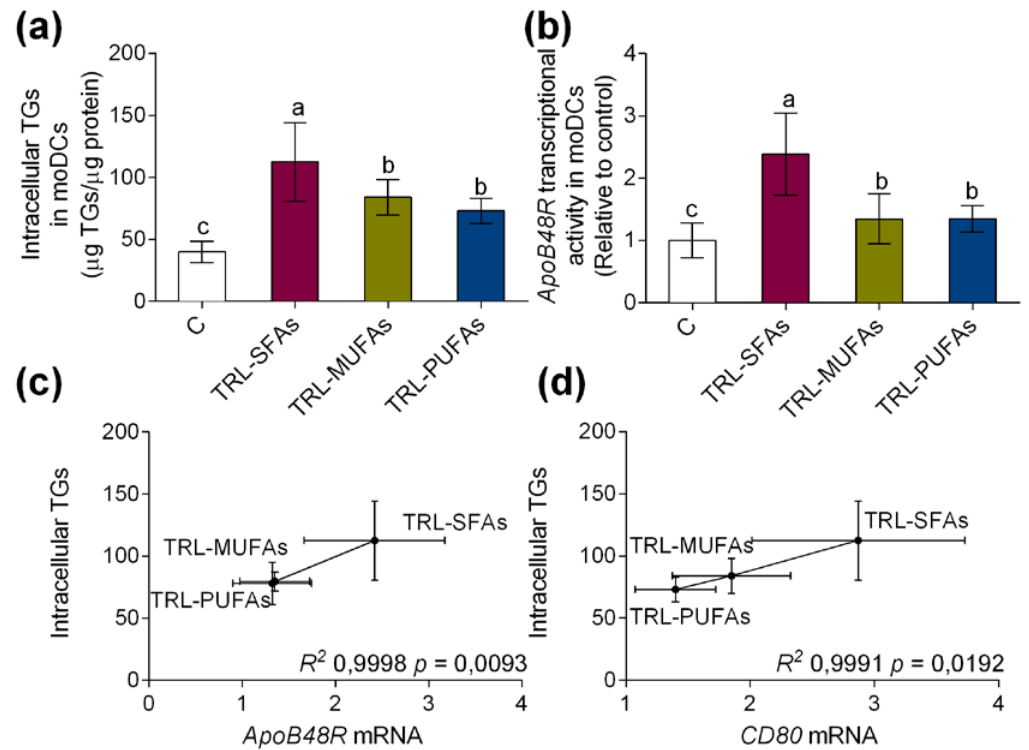
Figure 5. ( a ) Intracellular TGs accumulation and ( b ) In vitro apoB48R mRNA induced in moDCs after stimulation with TRL-SFAs, TRL-MUFAs and TRL-PUFAs at 100 µ g of TGs / mL for 6 days and in presence of GM-CSF and IL-4. ( c ) Correlation between apoB48R mRNA and ( d ) CD80 mRNA (DC activation marker) with intracellular TGs in moDCs. Control means non-treated cells in presence of GM-CSF and IL-4. Values are presented as means ± SD ( n = 6) and those marked with di ff erent letters are significantly di ff erent ( p < 0.05). TGs: